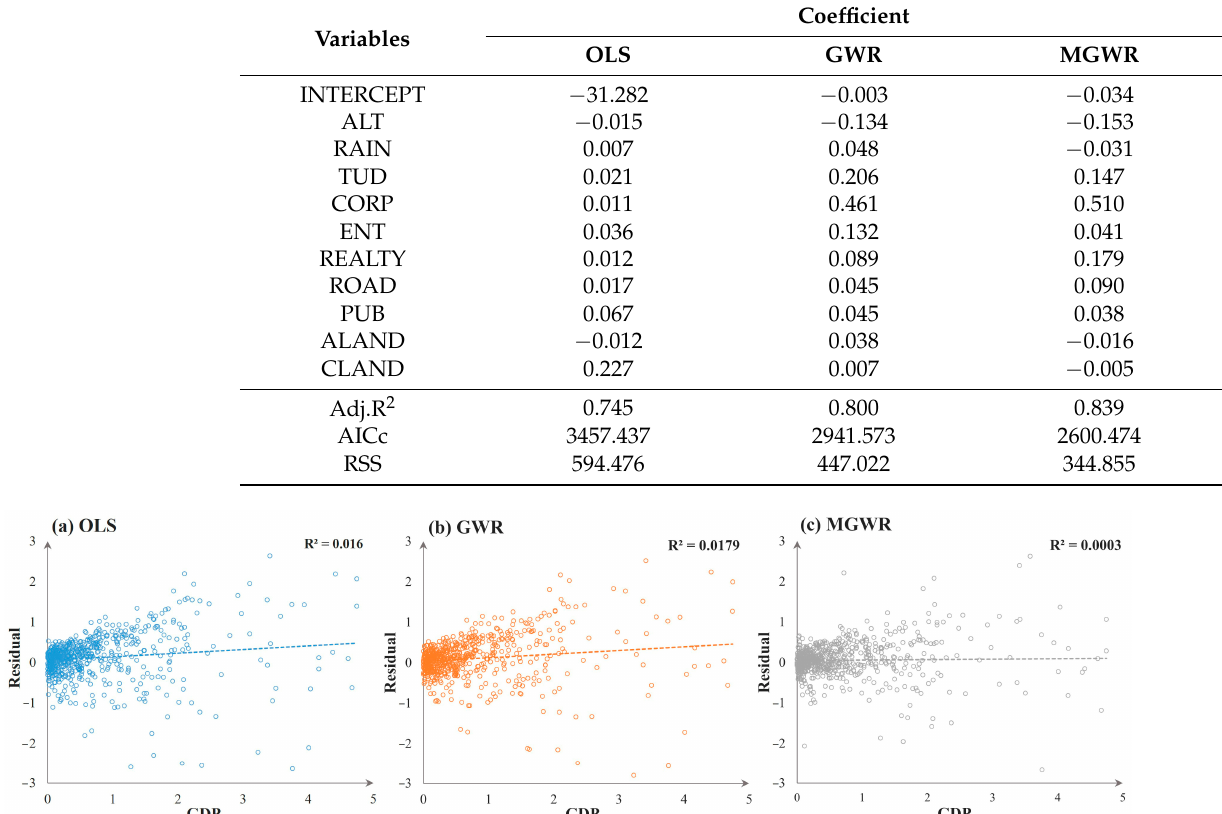
Table 2. Comparison of the regression results of three models.